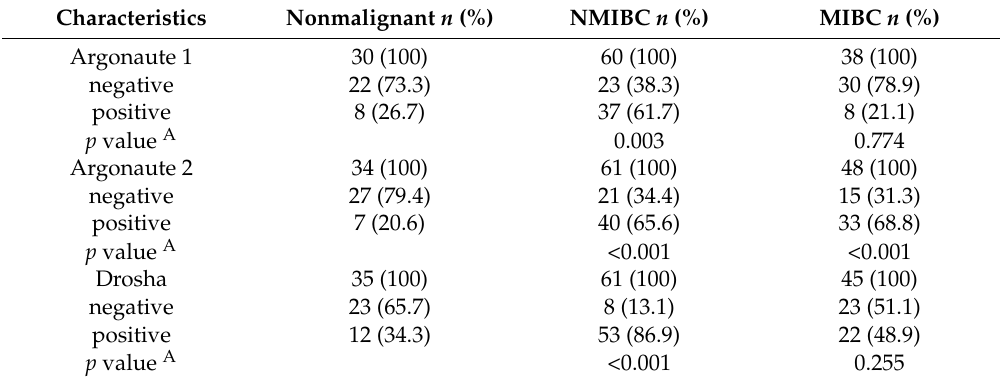
Table 2. Comparison of AGO1, AGO2, and Drosha expression in adjacent normal tissue to NMIBC as well as MIBC in valid